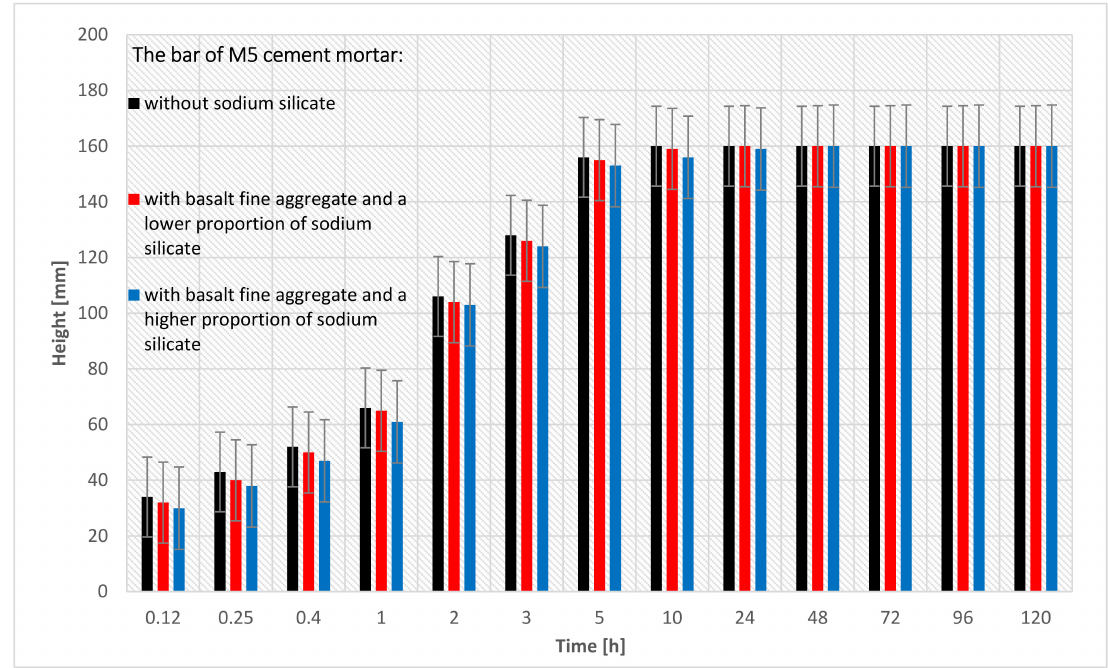
Figure 7. The results of the capillary suction of the M5 cement mortar bar with basalt fine aggregate: without sodium silicate, with a lower proportion of sodium silicate, and with a higher proportion of sodium